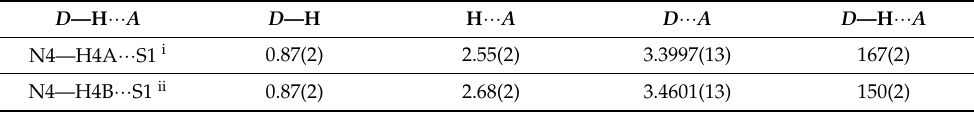
Table 6. Hydrogen-bond geometry (Å, ◦ ) for 4 .